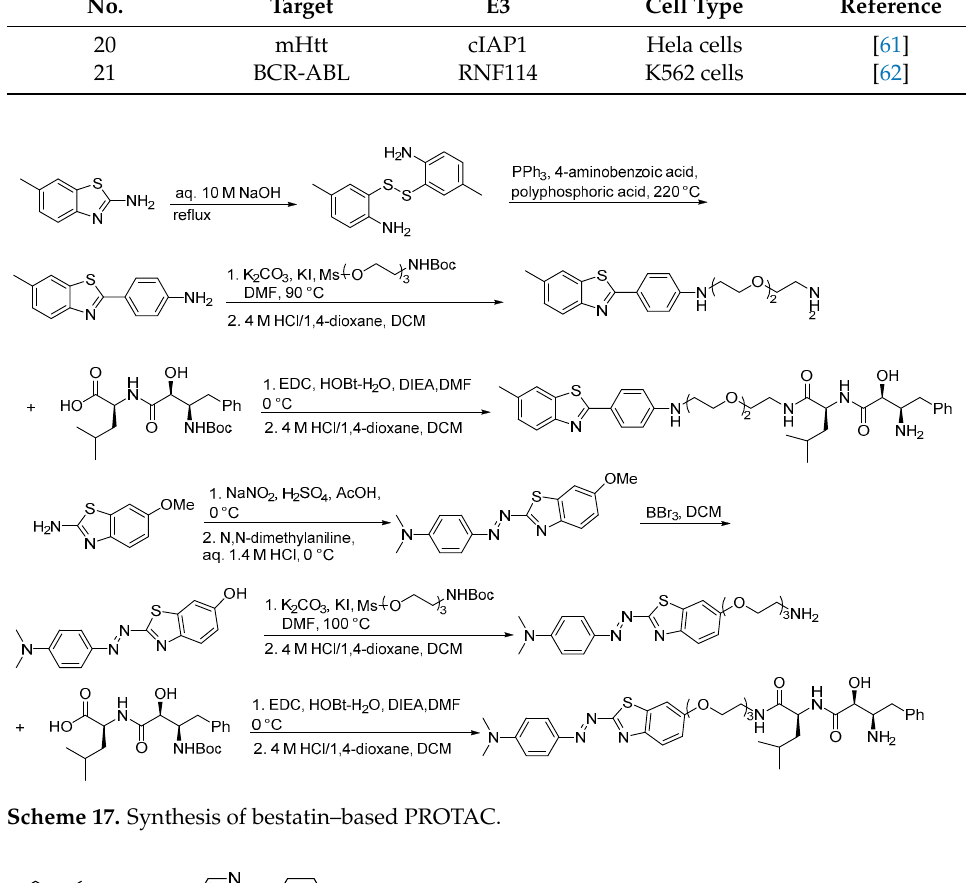
Table 10. Natural product targets 20–21.